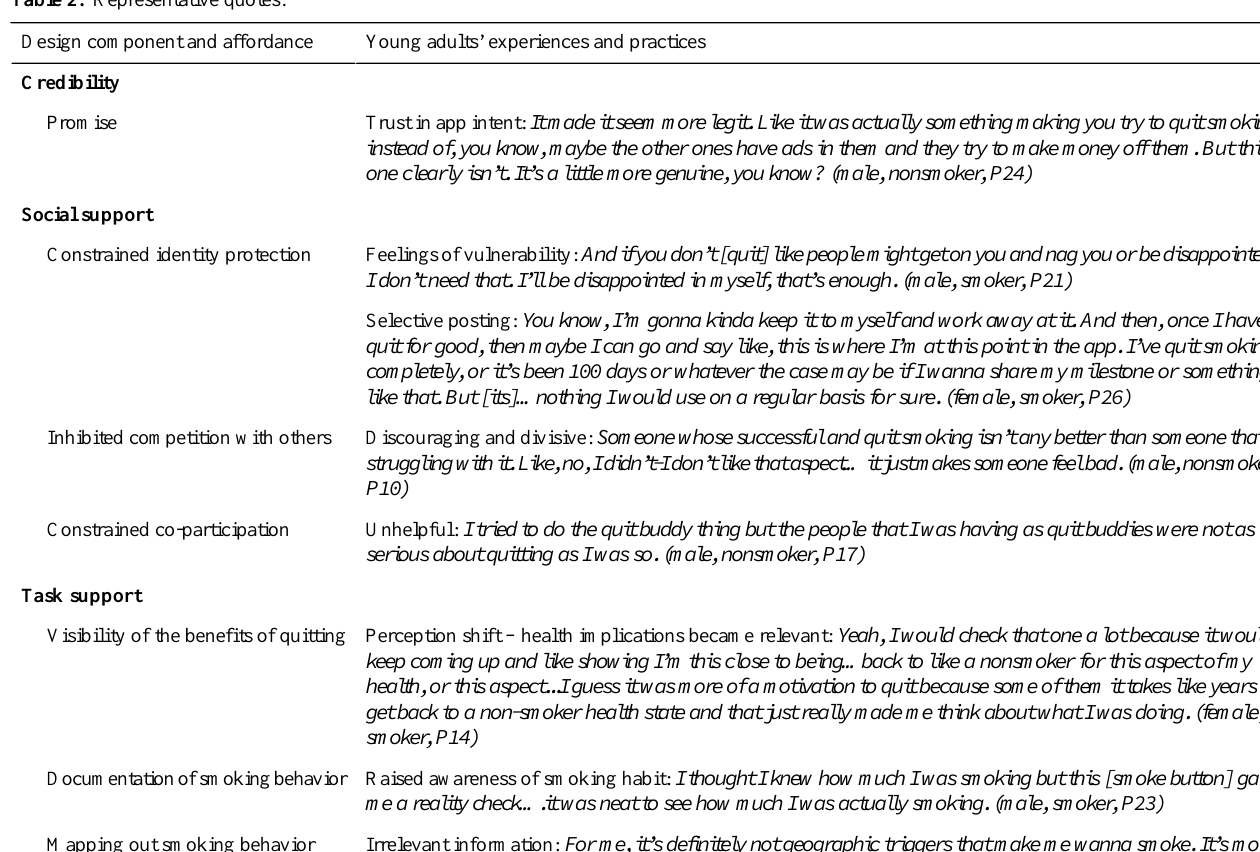
Table 2. Representative quotes.